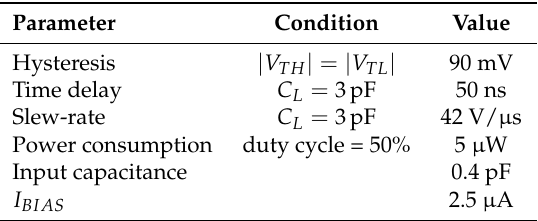
Figure 8. Simulated DC transfer characteristic of the comparator. Table 3. Simulated parameters for the